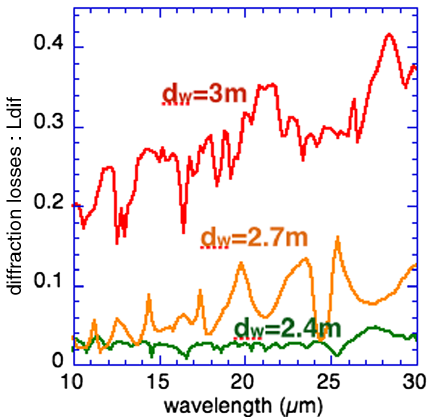
FIG. 15. Diffraction losses L waveleguide length d